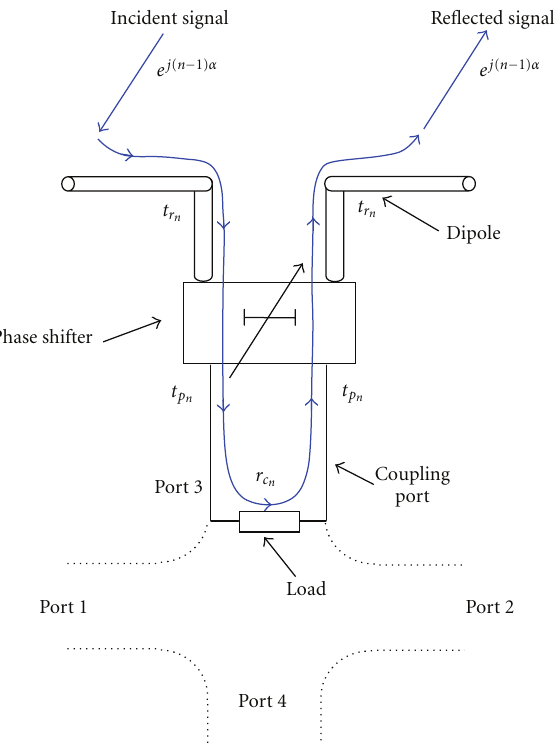
Figure 7: Signal reflection at the coupling port of the coupler. in the array, (ii) Previous antenna element in the array, (iii) Load terminating its own coupler, and (iv) Port (backward direction) through which it was received. Each of these signals gives rise to scattering and hence contributes to the RCS